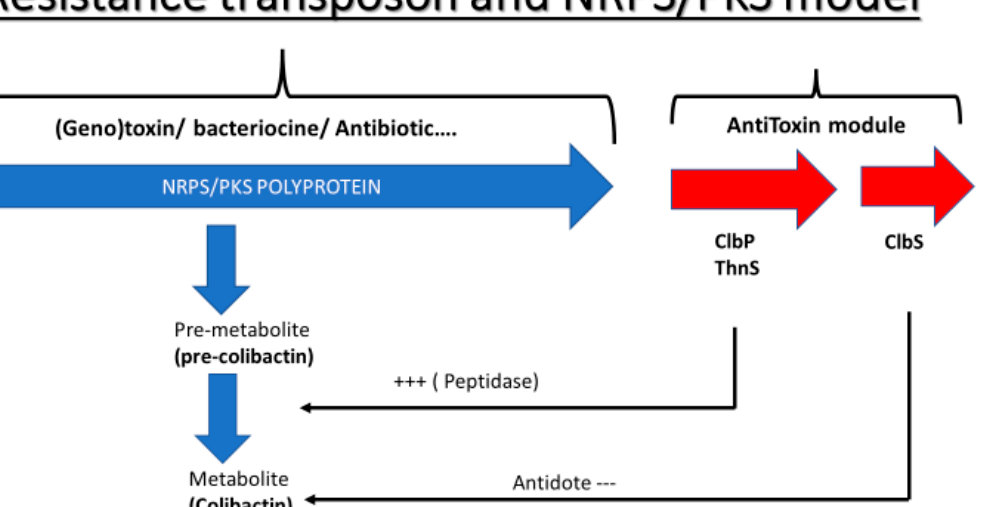
Figure 5. The schematic representation of the NRPS/PKS colibactin cluster as a toxin/antitoxin system. The first part of the cluster (in blue) composed by the sixteen first genes encode for the pre-colibactin metabolite (toxin) while the second part of this cluster (in red) represents the antitoxin module that acts as protector against the synthetized metabolite. (+++: Transformation of pre-colibactin to activated colibactin; ---: Inactivation of colibactin).